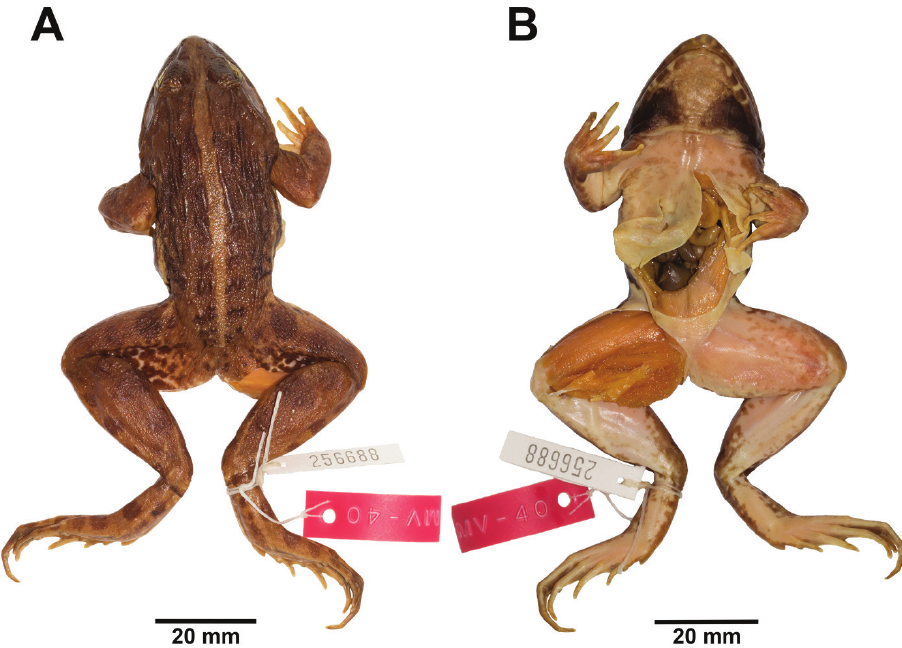
Figure 4. Adult male neotype of Fejervarya cancrivora (FMNH 256688) in preservative in A dorsal and B ventral